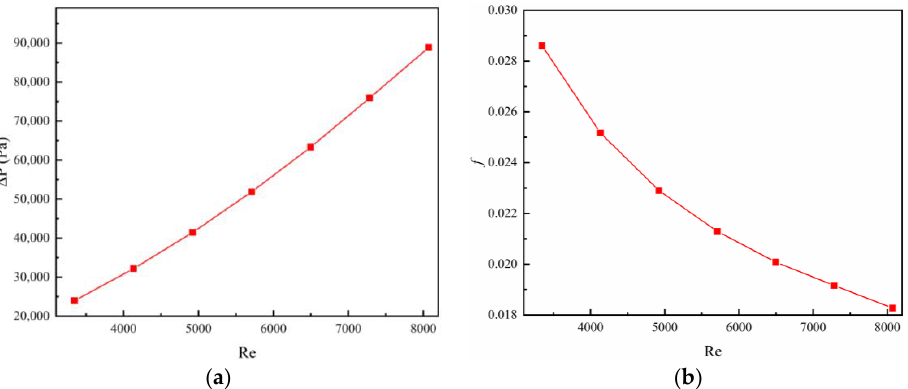
Figure 13. Distributions of pressure drop ( a ) and friction factor f ( b ) versus Reynolds numbers.